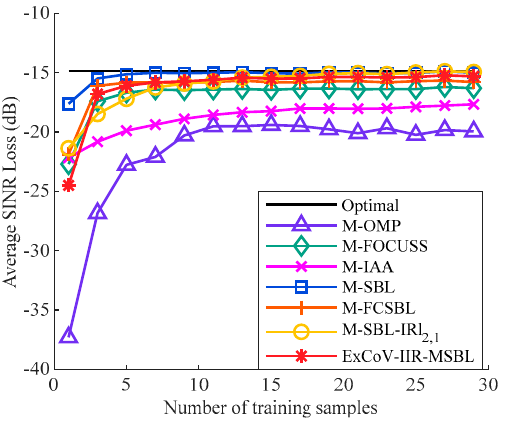
Figure 9. The average SINR loss versus the number of training samples with gain-phase error.